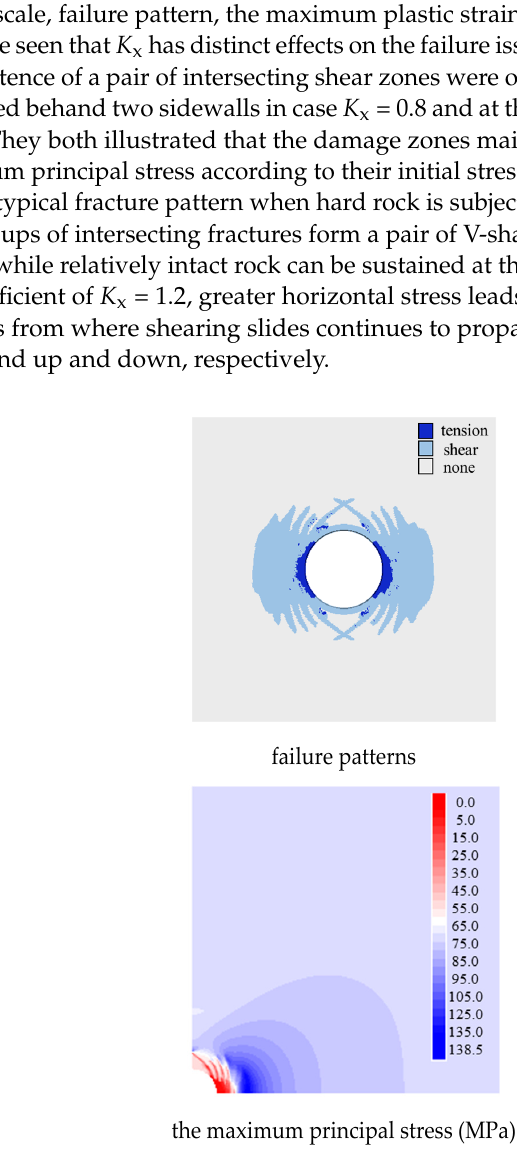
Figure 10. Stress state of surrounding rock along radial horizon.